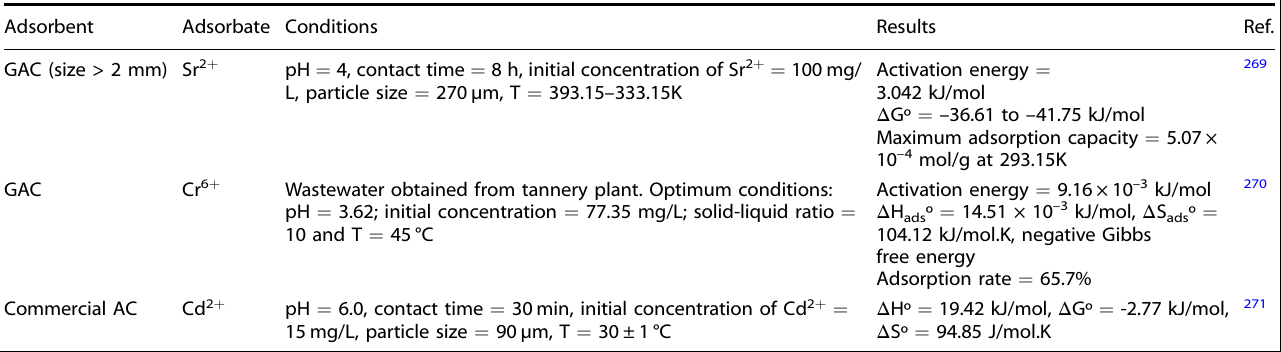
Table 2. Adsorption by AC for industrial wastewater treatment.